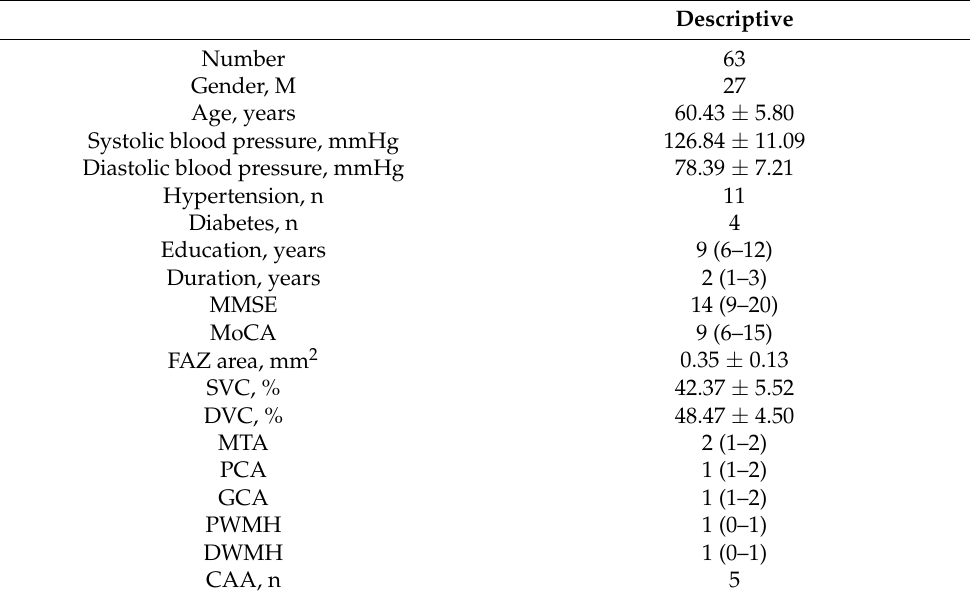
Table 1. Baseline characteristics of EOD patients.